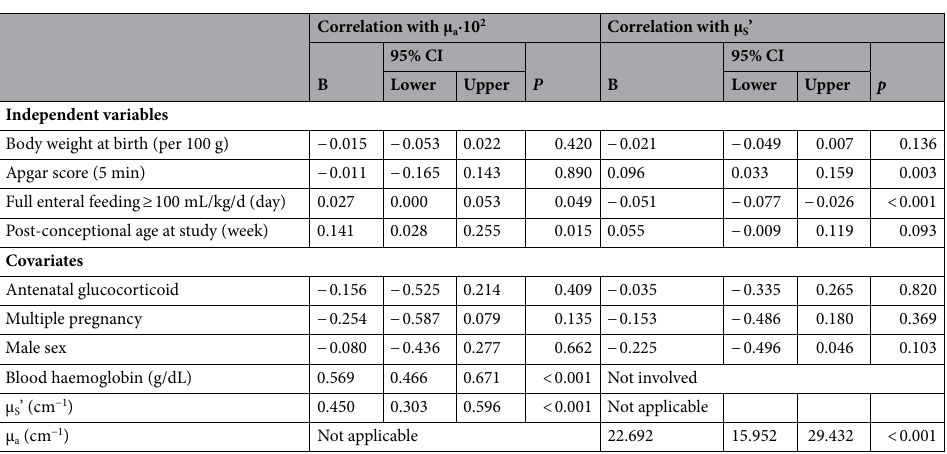
Table 3. Dependence of µ a and μ S ’ on clinical variables: multivariate analysis. The model is also adjusted for the wavelengths of near-infrared light and position of the head. B regression coefficient, CI confidence interval, µ a absorption coefficient, µ s ’ reduced scattering